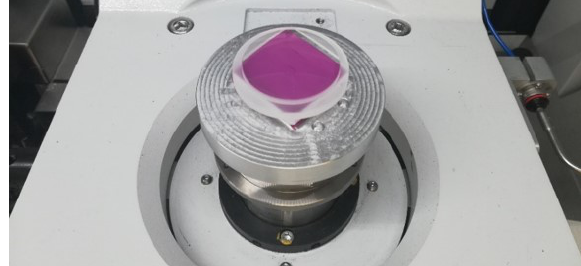
Fig. 4 Demonstrator element on MRF for form